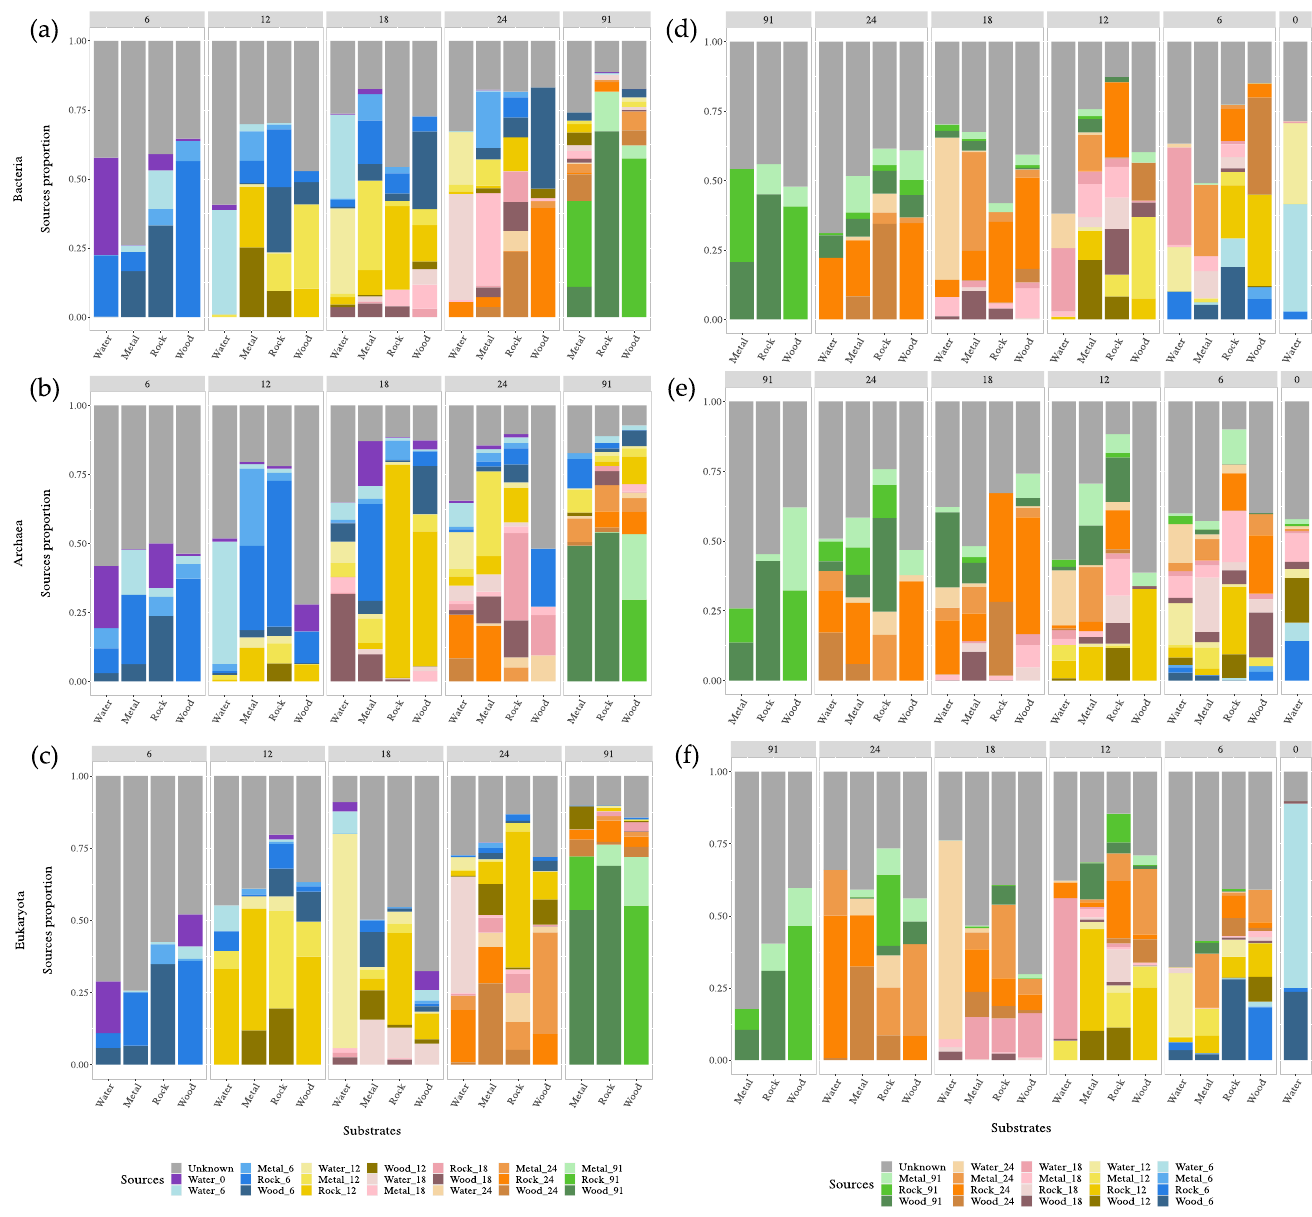
Figure 6. Microbial source tracking estimating the contribution of planktonic and sessile bacterial ( a ), archaeal ( b ) and eukaryote ( c ) communities from surficial into the deeper layers communities, or bacterial ( d ), archaea ( e ) and eukaryote ( f ) communities from the deeper into the surficial layers across the depth gradient and in the different substrates. Each color indicates a source corresponding to a substrate at a specific depth. Unknown sources are indicated in grey.